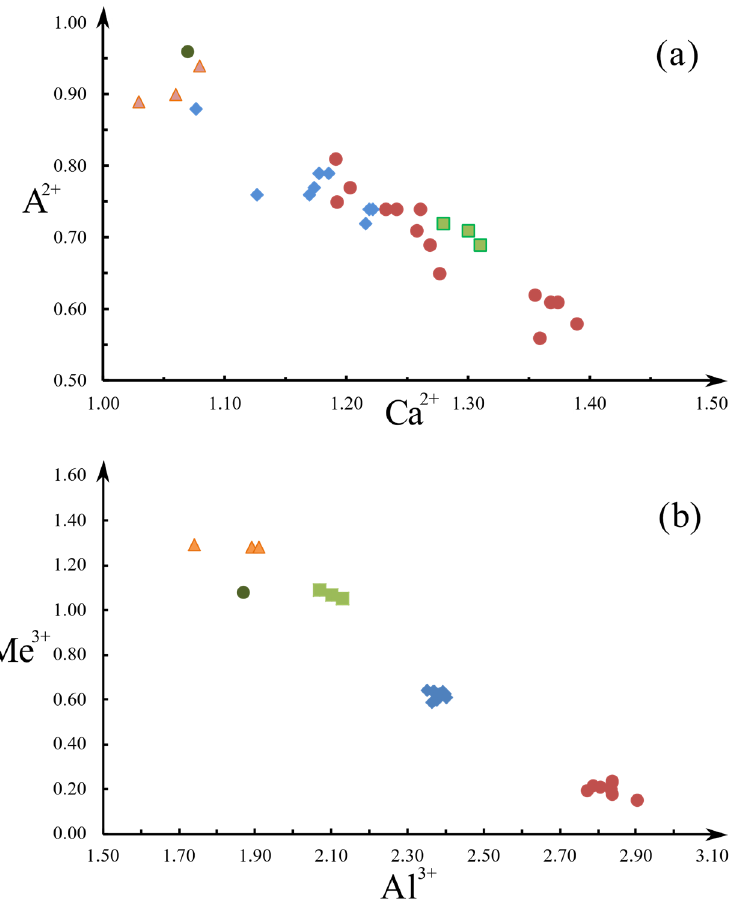
Figure 5. ( a ) Relationships between Ca vs. A 2+ and Al vs. Me 3+ ( b ) in zoisite-(Pb) (blue rhombus) and hancockites. Hancockite data from present study are denoted as brown circles, Sterling Hill [43] as yellow triangles, Jakobsberg [26] as dark green circle, and Nezilovo [44] as light green squares.